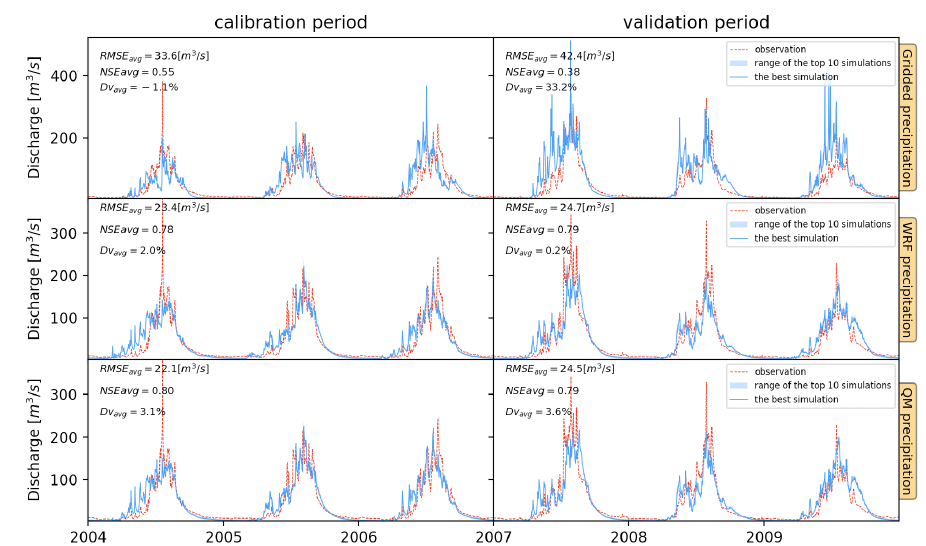
Figure 5. The simulated discharges using three precipitation datasets (the GRIDDED precipitation, the WRF downscaled precipitation, and the QM frequency-corrected precipitation data). The ten best simulation results calibrated by the SCE-UA algorithm for each precipitation dataset are shown in a blue range. The range is relatively narrow because the ten best simulation results are very close. The simulation period is divided into the calibration period and the validation period. The accuracy indicators (NSE, RMSE, and Dv) of the ten best simulation results were averaged to show the perfor- mance of different precipitation datasets. The dashed red line represents the observed